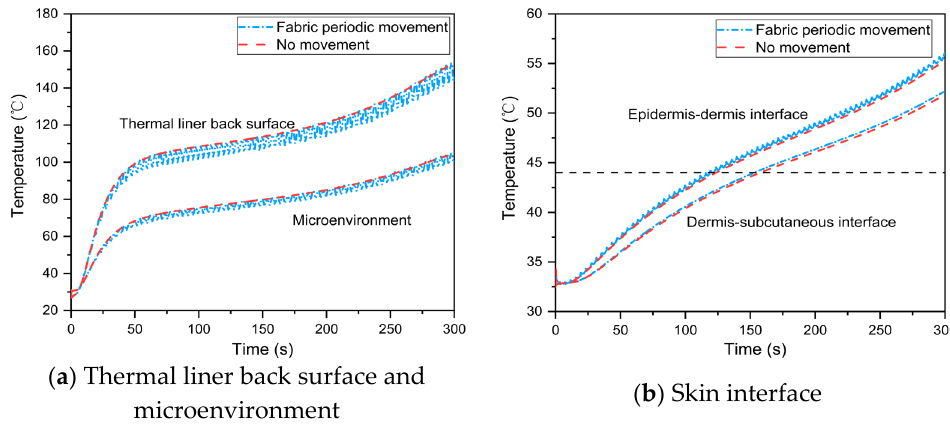
Figure Figure 8. Effect of the fabric periodic movement on temperature distribution in the skin–microenvi- ronment–fabric system.